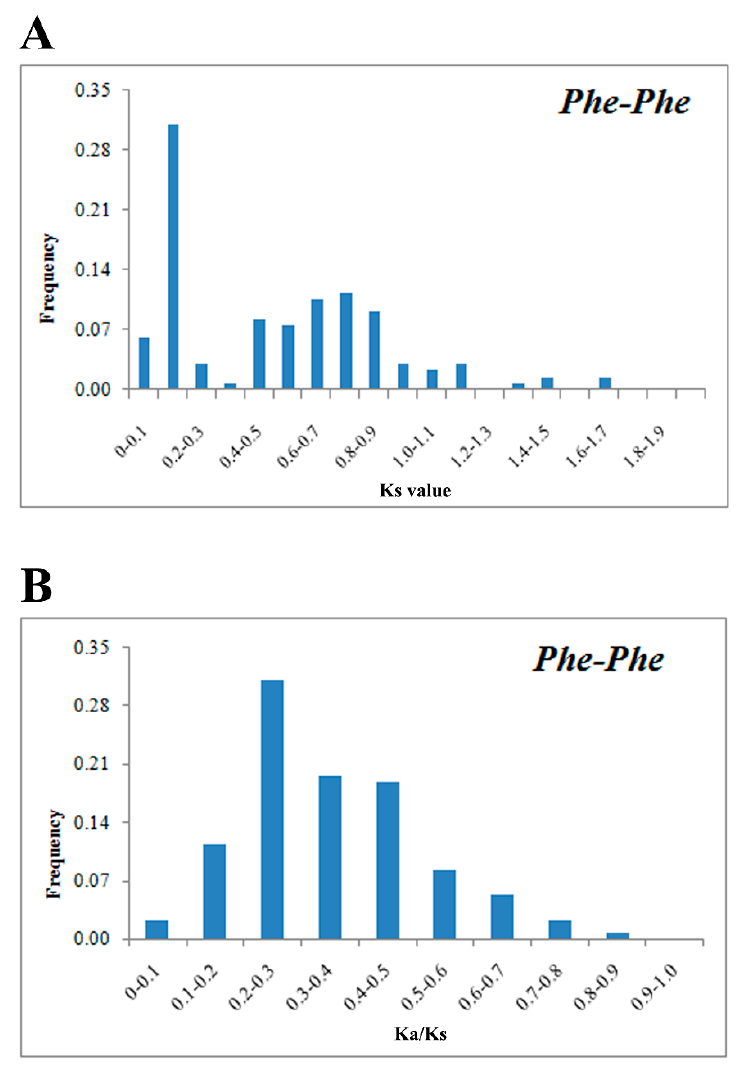
Figure 5. Ks and Ka / Ks value distribution of the bZIP genes in the genomes of moso bamboo paralogous gene-pairs ( Pe - Pe ), viewed through the frequency distribution of relative Ks and Ka / Ks modes. Distribution of Ks and Ka / Ks values were obtained from paralogous gene-pairs ( Pe - Pe ) in the moso bamboo genome ( A and B ).